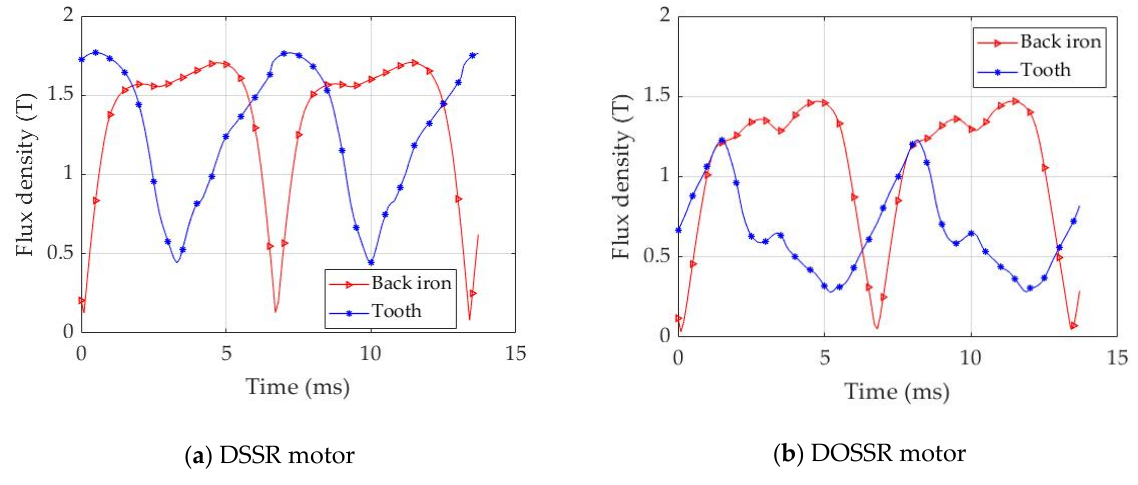
Figure 16. Flux density for the DSSR motor with PM thickness of 4.5 mm and the DOSSR motor with PM thickness of 5 mm.